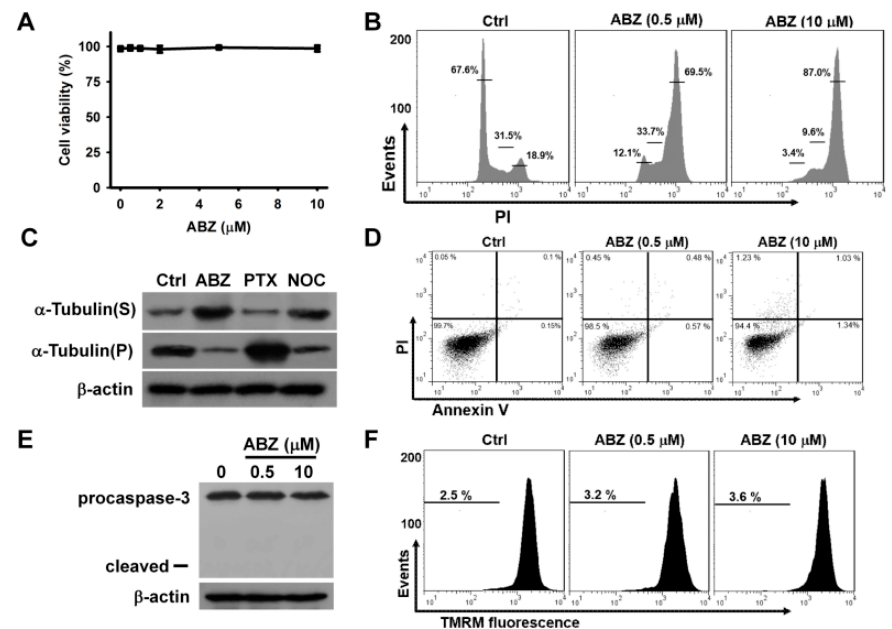
Figure 1. Cytotoxic effect of albendazole (ABZ) on K562 cells. Without specific indication, K562 cells were incubated with indicated ABZ concentrations for 24 h. ( A ) Concentration-dependent effect of ABZ on cell viability. K562 cells were incubated with indicated ABZ concentrations for 24 h. Cell viability was determined using MTT assay. Results are expressed as the percentage of cell viability relative to the control. Each value is the mean ± SD of three independent experiments with triplicate measurements. ( B ) Cell cycle analysis of ABZ-treated K562 cells. ( C ) Effect of ABZ, nocodazole, and paclitaxel on tubulin polymerization. K562 cells were treated with 0.25 μ M nocodazole (NOC), 0.5 μ M ABZ or 0.2 μ M paclitaxel (PTX) for 24 h, respectively. Then, the cells were lysed and fractionated from cytosol (supernatant, S) to cytoskeletal (pellet, P) extracts. The extracts were subjected to Western blot analysis for α -tubulin and β -actin analysis. ( D ) Flow cytometry analyses of annexin V-PI double staining ABZ-treated cells. On the flow cytometric scatter graphs, the left lower quadrant represents remaining live cells. The right lower quadrant represents the population of early apoptotic cells. The right upper quadrant represents the accumulation of late apoptotic cells. ( E ) Western blot analyses of procaspase-3 degradation in ABZ-treated cells. ( F ) Effect of ABZ on ΔΨ m in ABZ-treated cells. Previous studies have shown that benzimidazole anthelmintics potentiate the cytotoxicity of BH3 mimetic ABT-263 (a BCL2/BCL2L1 inhibitor) on non-small cell lung cancer [20]. Haschka et al. [17] found that BH3 mimetic ABT-737 (a BCL2/BCL2L1 inhibitor) increasingly triggers the apoptosis of mitotic cells, arrested by nocodazole induction. BH3 mimetics have been reported to induce cell death through the activation of the intrinsic apoptosis pathway [17,20]. To examine whether the inability of ABZ to induce the death of K562 cells was associated with defects in activating intrinsic apoptosis machinery, the cytotoxic effect of ABT-263 on ABZ-treated and -untreated K562 cells were analyzed. Since K562 cells exposed to 0.5 μ M ABZ showed a marked G2/M cell cycle arrest, we used this concentration of ABZ to investigate the effect of combination with ABT-263 on apoptosis induction over 24-h. Treatment with ABT-263 plus ABZ induced the death of K562 cells at a higher rate compared with ABT-263 alone (Figure 2A). ABT-263 also promoted the death of ABZ-treated cells (Figure 2B). In comparison with a singular treatment of ABT-263 or ABZ, combinatorial treatment of ABT-263 and ABZ increased the loss of ΔΨ m (Figure 2C) and apoptosis (Figure 2D) in K562 cells. Consistently, in comparison with either agent alone, the combination of ABT-263 and ABZ markedly increased the production of cleaved caspase-3 and PARP in K562 cells (Figure 2E). Co-